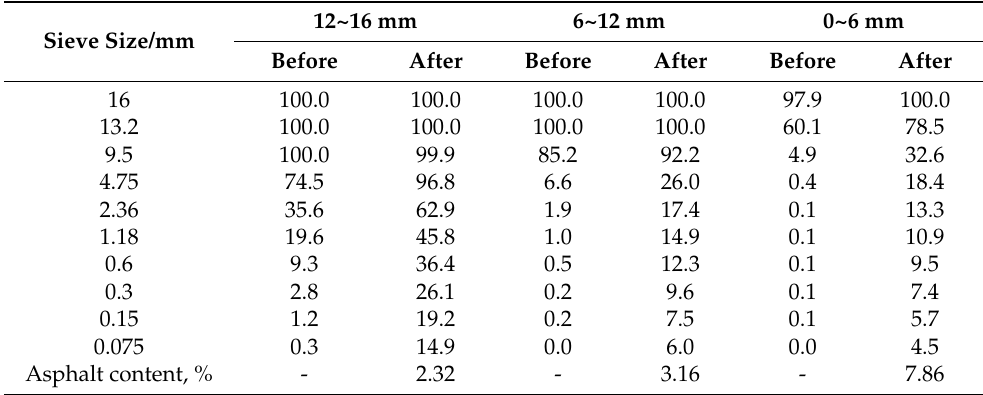
Table 3. Gradation and asphalt content of RAP before and after